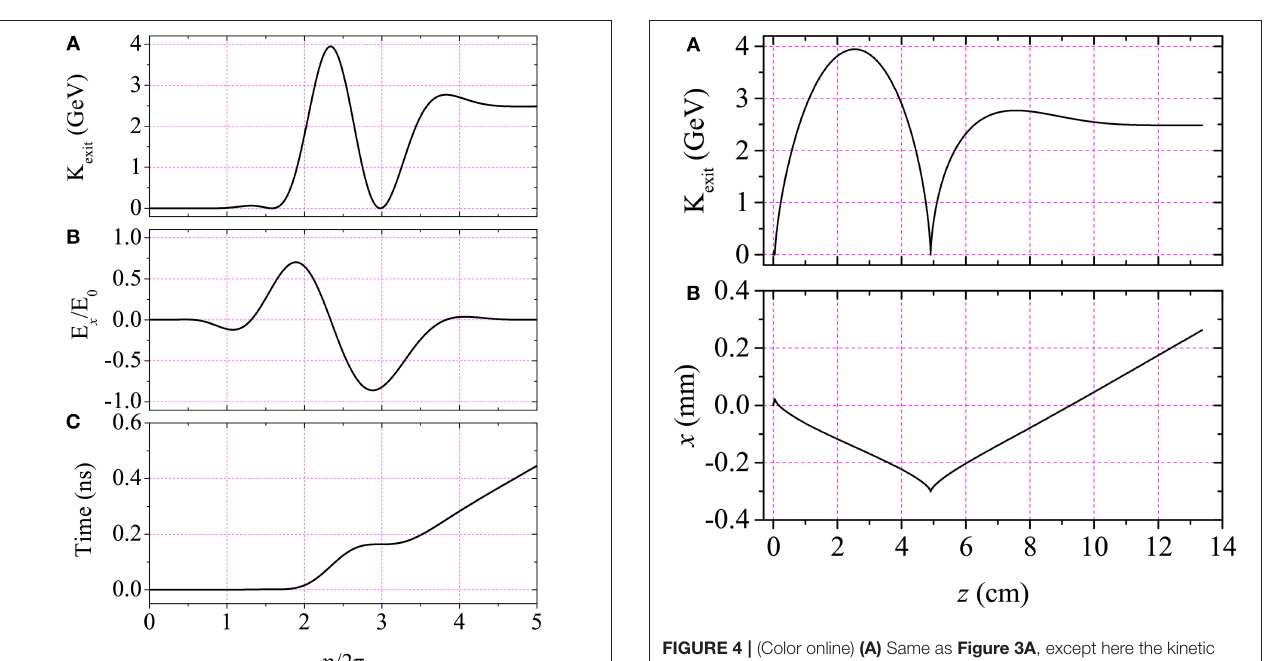
FIGURE 4 | (Color online) (A) Same as Figure 3A , except here the kinetic energy evolution is plotted against the axial excursion distance, z . (B) Trajectory of the same electron in the xz − plane (the polarization plane).